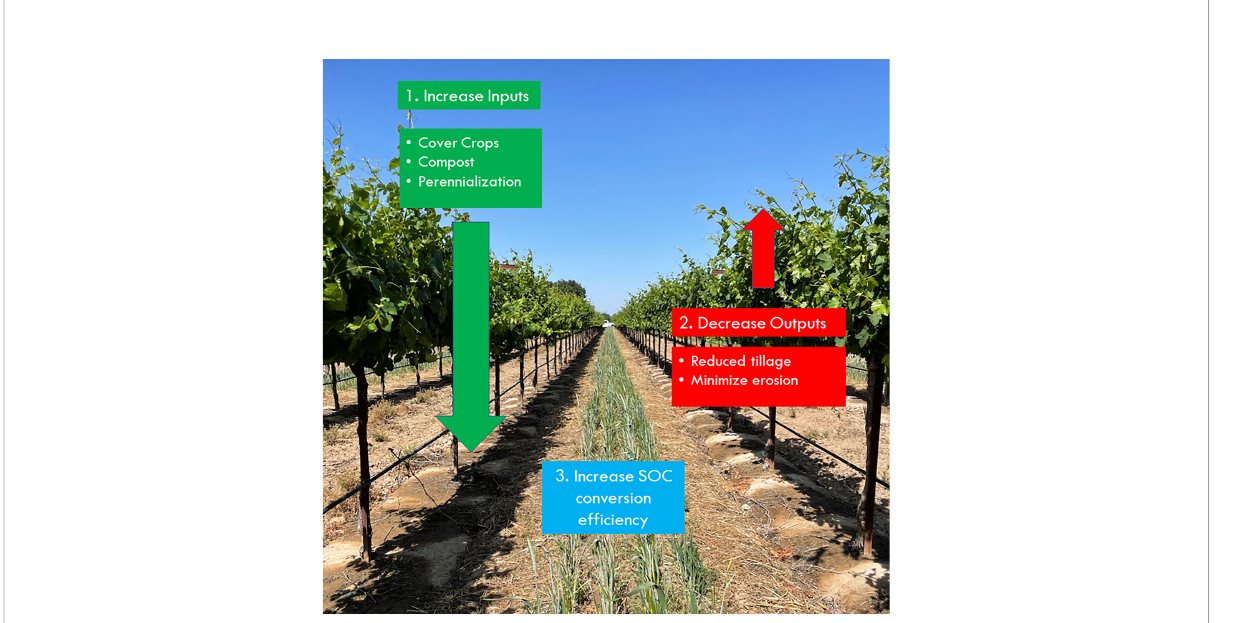
FIGURE 1 Framework for increasing soil organic carbon (SOC) conversion ef fi ency in vineyards by increasing inputs of cover crops, compost, and perennializaiton and decreasing outputs from tillage and erosion